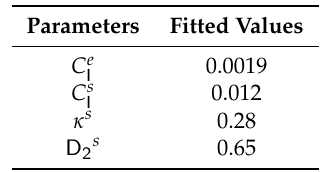
Table 7. Parameters of the flow-dependent pARD-RSC model for a PBT